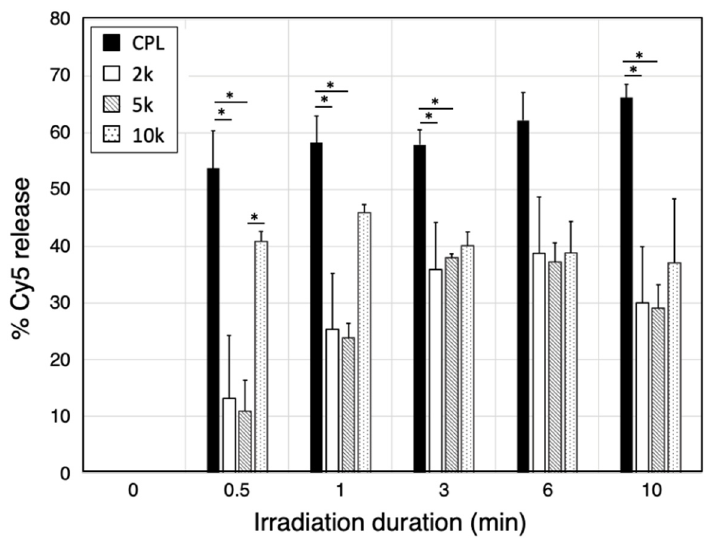
Figure 3. Cy5 release efficiency of Cy5-PC-Latex (CPL), mPEG(2k)-Cy5-PC-Latex (2k), mPEG (5k)- Cy5-PC-Latex (5k), and mPEG (10k)-Cy5-PC-Latex (10k). Release rates were calculated by first measuring the fluorescence of the beads through flow cytometry, then converting the rate of decrease in fluorescence intensity to rate of release. N = 3 for all samples. * p < 0.05 indicate significance. Error bars denote standard deviation.